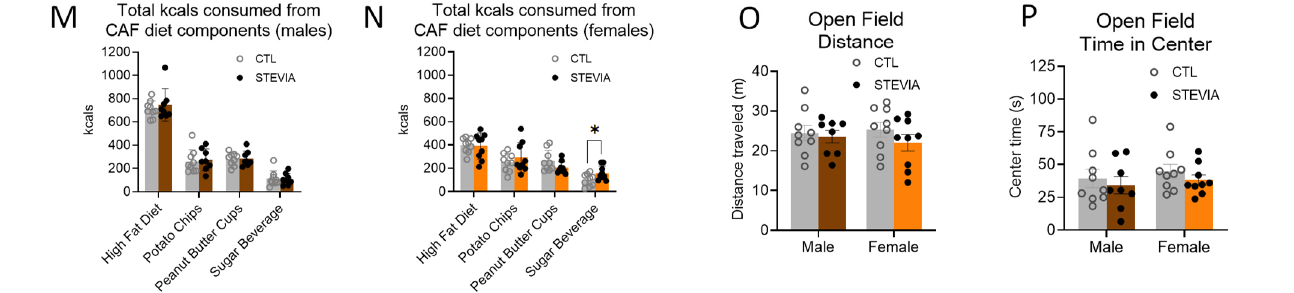
Figure 3. Effects of early life consumption of stevia in rats on energy balance parameters during